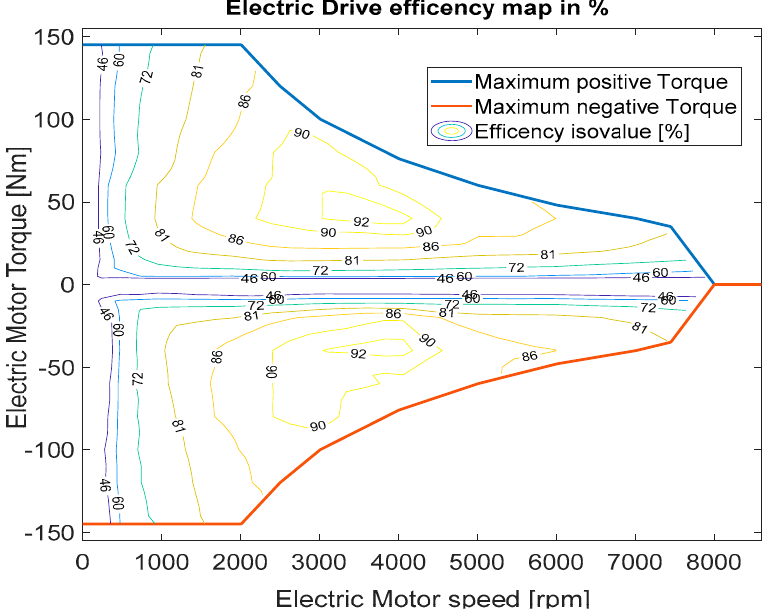
Figure 6. Electric motor cartography presenting power loss within EM torque and speed limits.